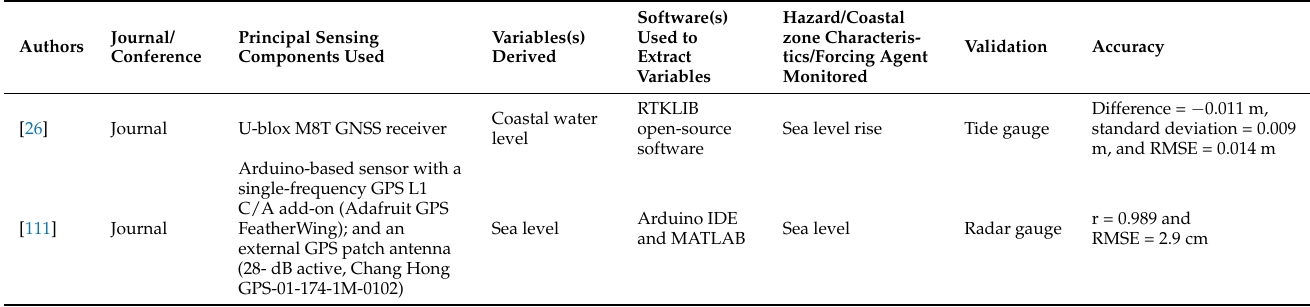
Table 5. Summary of papers on GNSS-R, WSN, GPS-Buoy, DIY pressure sensor/gauge, water level sensor, ground-based beach profiler, high wind speed recording system, UAV-RTK Lidar system, and cable-mounted robot for nearshore monitoring, which includes: type of paper, principal sensing components, parameters derived, software used to extract parameters, hazards/forcing agents monitored, validation, and